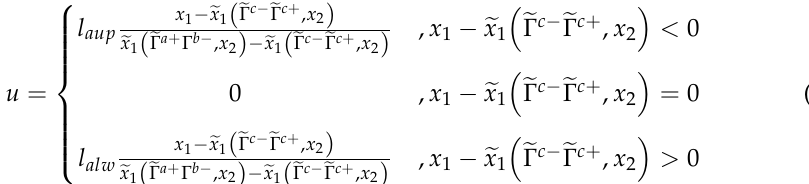
According to Equations (5)–(7), the point c + and overlap with each other on the phase plane. Point a + phase plane; the ordinate values of c + ordinate values of point c −